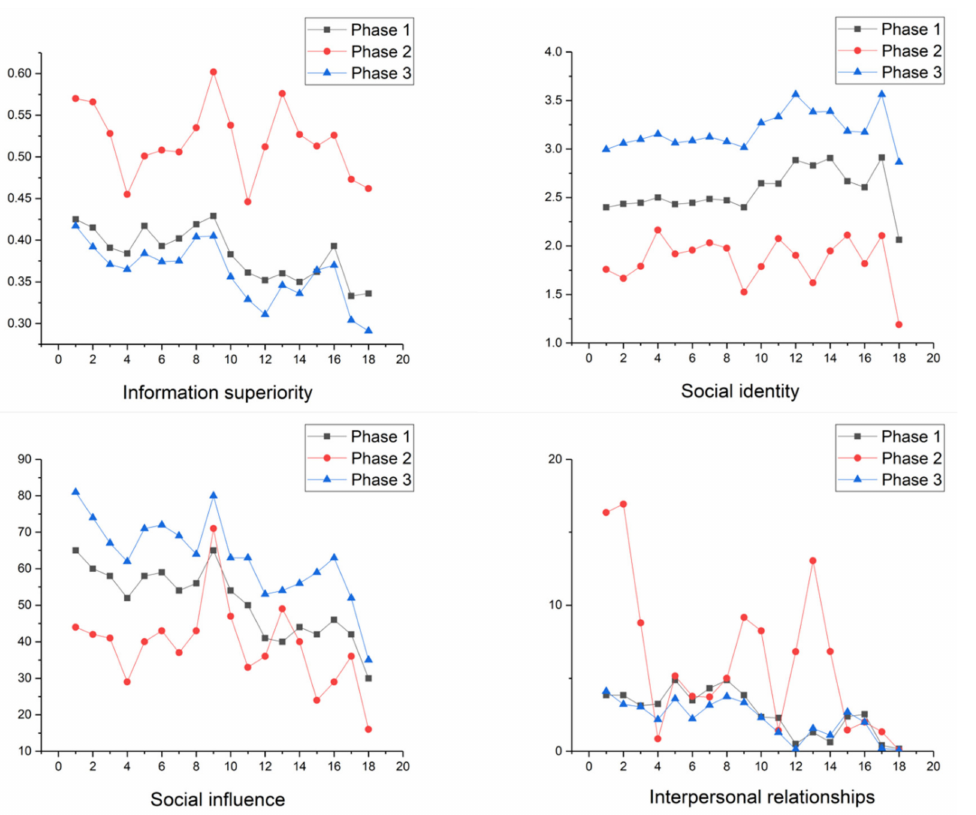
Figure 3. Bridging social capitals during different phases of the disaster.